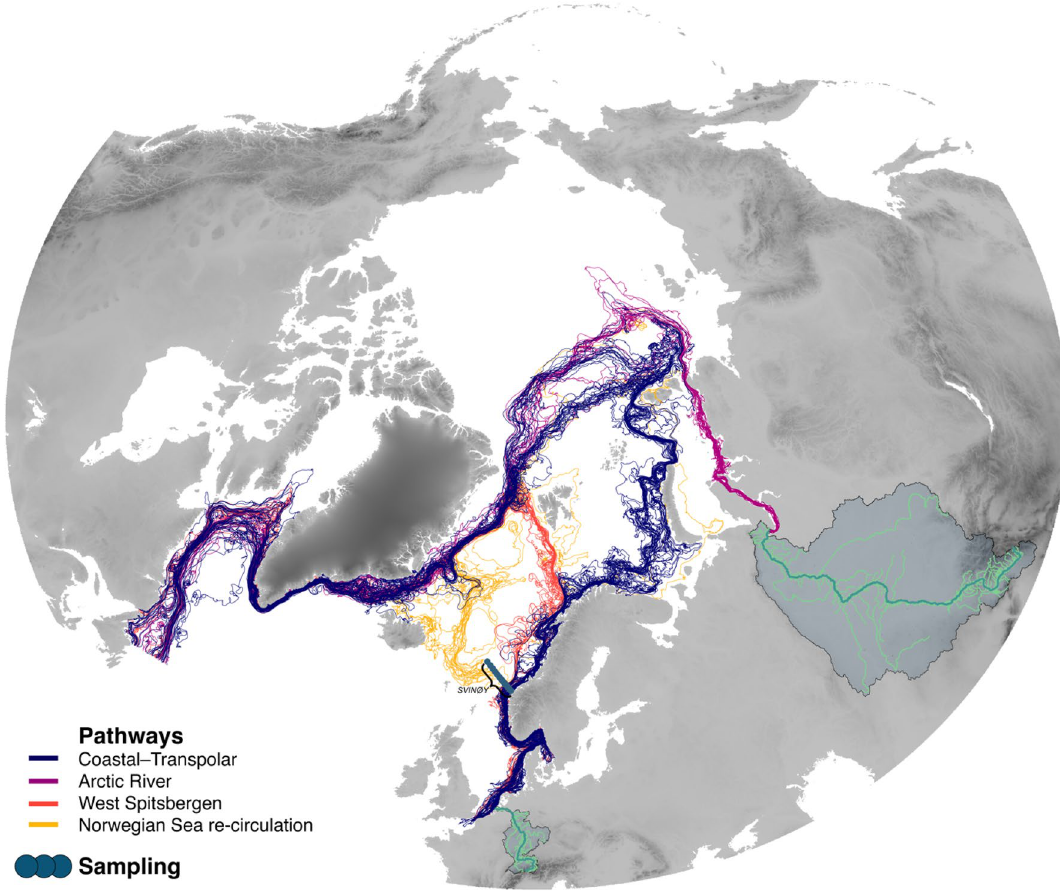
Figure 2. Main drift pathways of European BMP through the Arctic Mediterranean. Here pathways of microplastic particles discharged with the Rhine is used as example (navy blue lines), the largest source of river-borne microplastic in northern Europe (see Schmidt et al. 4 ); with alternative pathways along the West- Spitsbergen Current (orange lines); and particles re-circulated in the Nordic Seas, frequently sampled during the Svinøy transect (yellow lines). Also depicted are pathways of plastic particles discharged from Ob river, being the largest estimated point source in the Arctic Ocean (purple lines). Note the small, dark blue dots representing the 17 sampling locations along the standard oceanographic transect “Svinøy”, starting at 62° N off the western coast of Norway (see Figure S1 for detailed map). For map source data, see Fig.